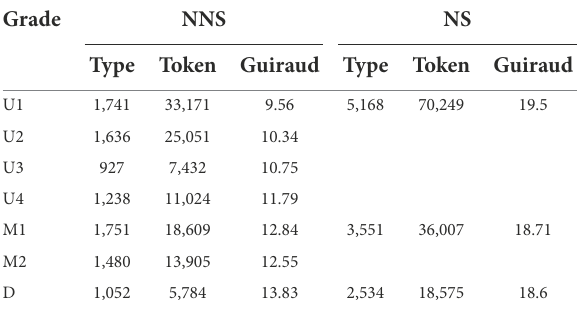
TABLE 2 Types, tokens, and Guiraud index in essays by